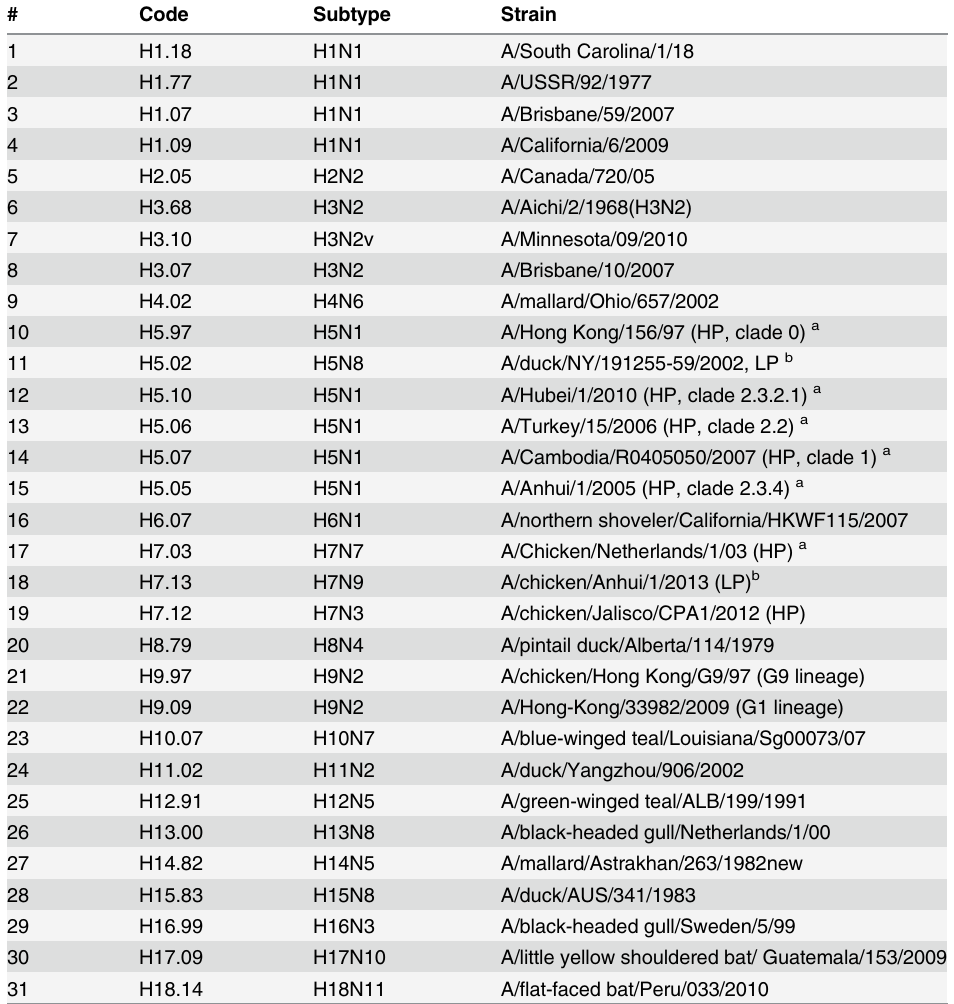
Table 1. Recombinant HA1-proteins included in the protein